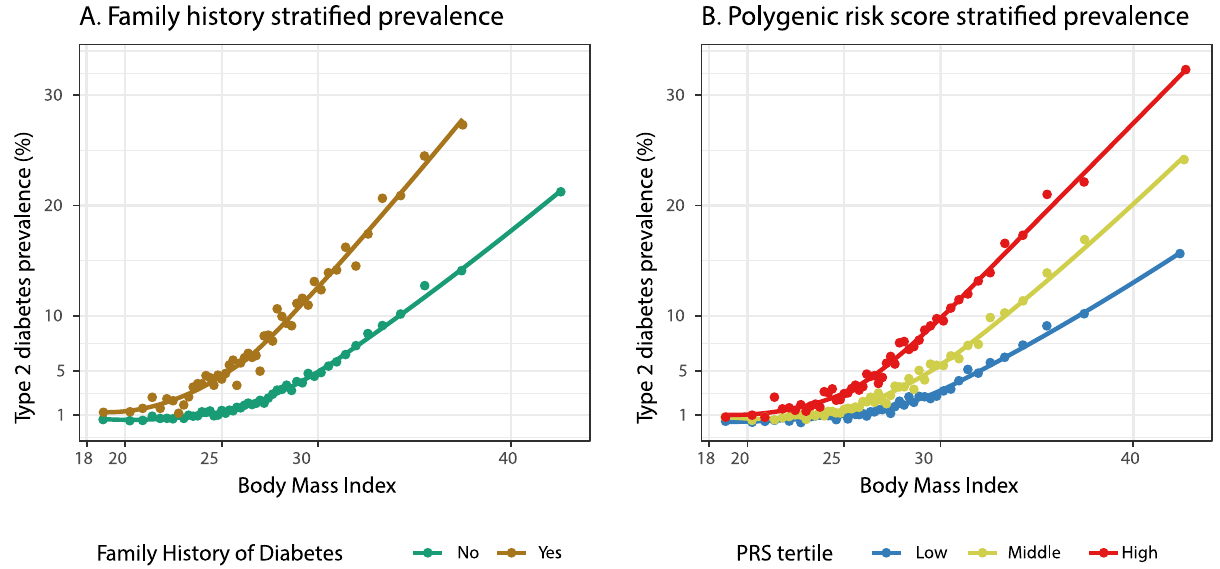
Fig 1. Variation of type 2 diabetes prevalence with BMI, family history, and polygenic risk. Within each category, 50 bins of equal numbers of individuals with consecutive BMI values were selected, and the average BMI and percent of individuals diagnosed with type 2 diabetes are shown. Curves were fit using LOESS regression [33]. Individuals were stratified by (A) family history of diabetes or (B) polygenic risk score (PRS) tertile.